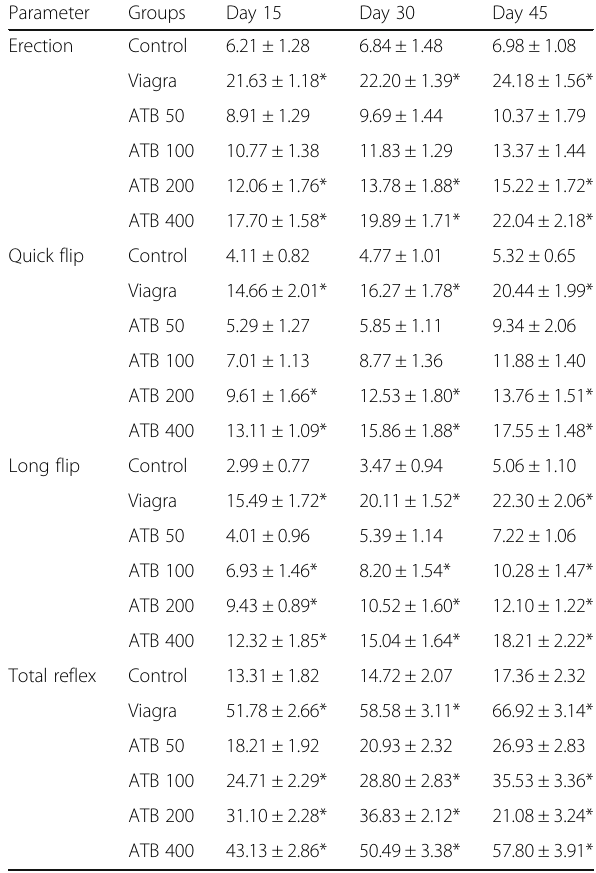
Table 4 Effect of ATB on testicular levels of ALP and ACP